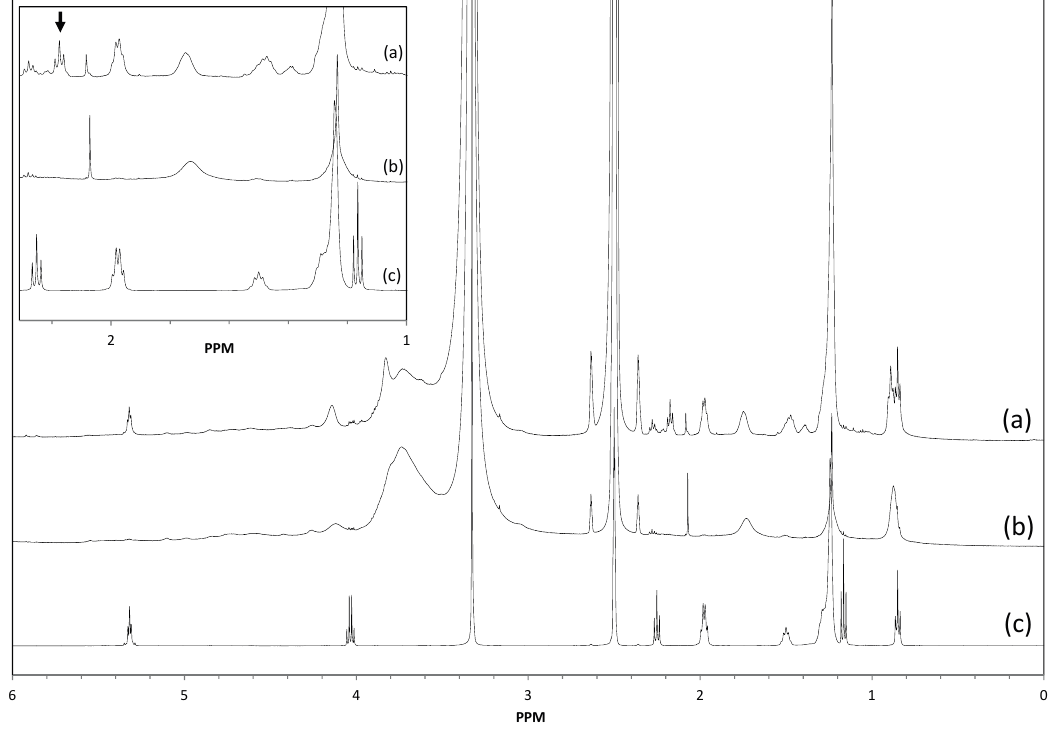
Figure 5. Respective 1 H-NMR spectra of lignin oleate extracted from the [C 4 C 1 mim][OTf]/ [C 4 C 1 mim][PF 6 ] binary system with the immobilized lipase B from Candida antarctica (a); control Kraft lignin extracted from the [C 4 C 1 mim][OTf]/[C 4 C 1 mim][PF 6 ] binary system without enzyme (b) and ethyl oleate